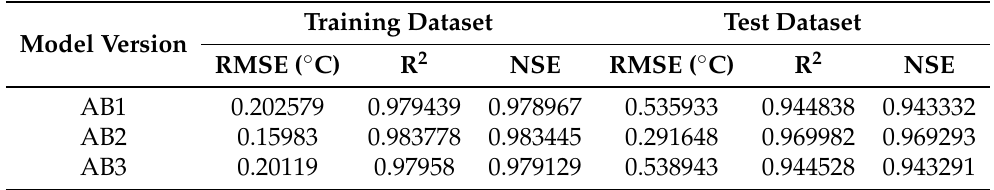
Table 5. Performances of AdaptiveBoosting Regressor in modeling water temperature (WT: ◦ C),